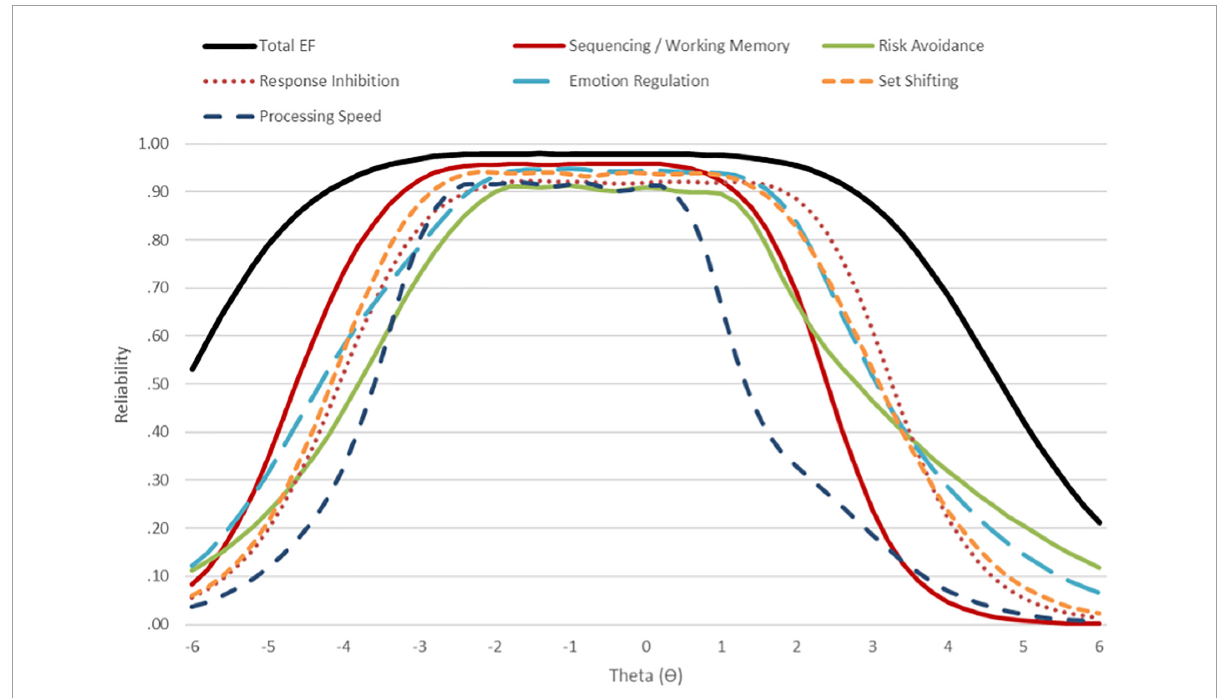
FIGURE2 Conditional reliability for the Executive Functioning Scale (EFS) total scale and subscales.